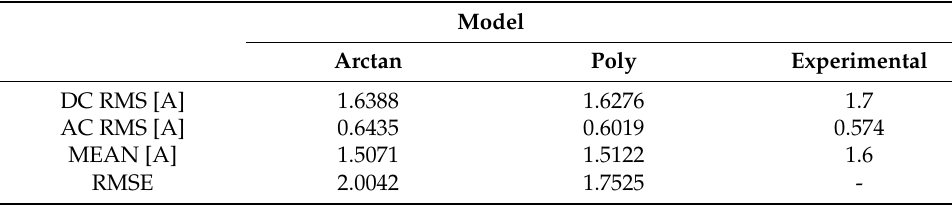
Table 1. Comparison of characteristics parameters of the current.